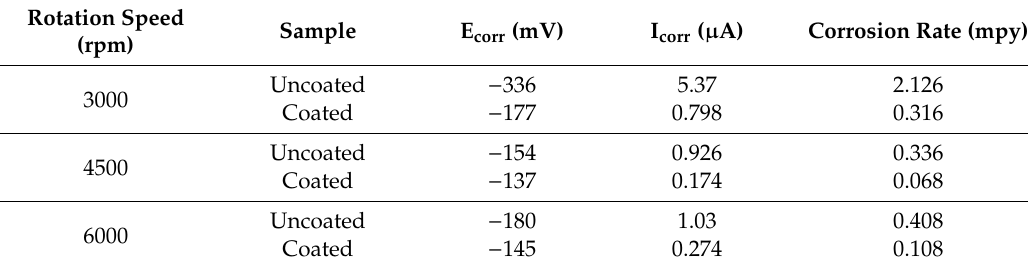
Figure 10. Comparison of potentiodynamic polarization curves at various rotational speeds of erosion corrosion particles. Table 3. Electrochemical values of the uncoated SS316 and coated samples in 0.1M NaCl at 25 °C.